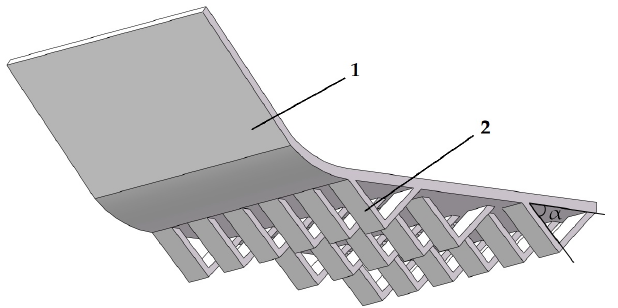
Figure 5. Bottom structure of weeding board. 1. Slide structure 2. Weeding teeth.